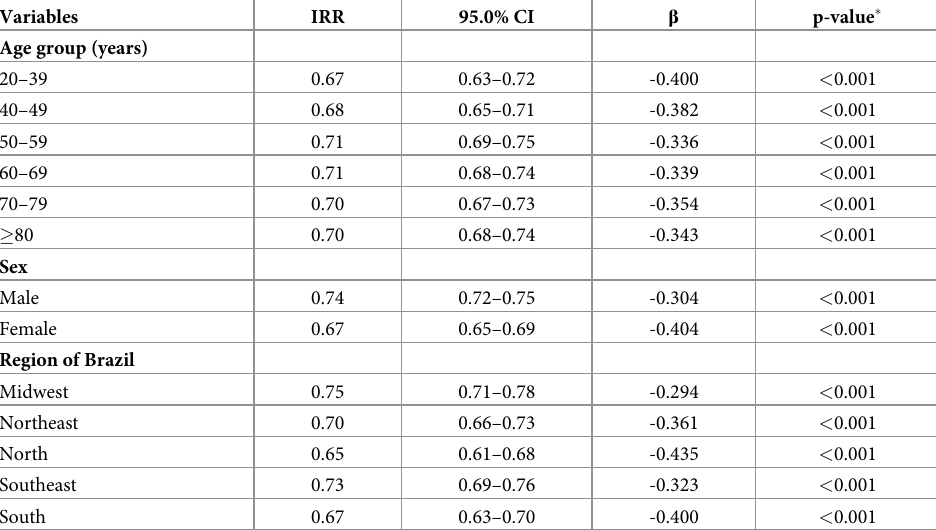
Table 9. Poisson multiple regression models of the impact of the coronavirus disease pandemic on the hospitali- zation rate for cardiovascular disease in Brazil according to subgroups by age group, sex, and region of Brazil.